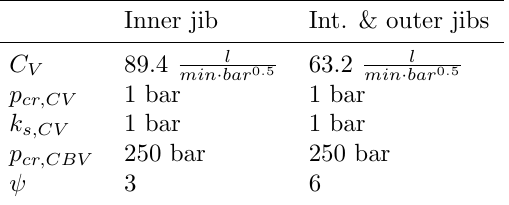
Table 5: CBV model